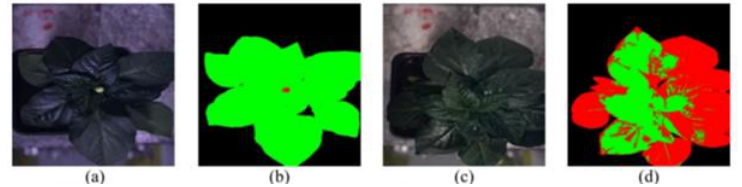
Figure 13. Sample images of OR-AC-GAN (a hyperspectral imaging model) [112] . In Figure 13, the resultant images are taken from the proposed method described in [112] . The green-colored portion indicates the healthy part of the plant; the red portion denotes the infected portion. Note that ( a ) and ( b ) are the healthy plant images as there is no red color indication, whereas ( c ) has infected disease which can be seen in its corresponding figure ( d ).